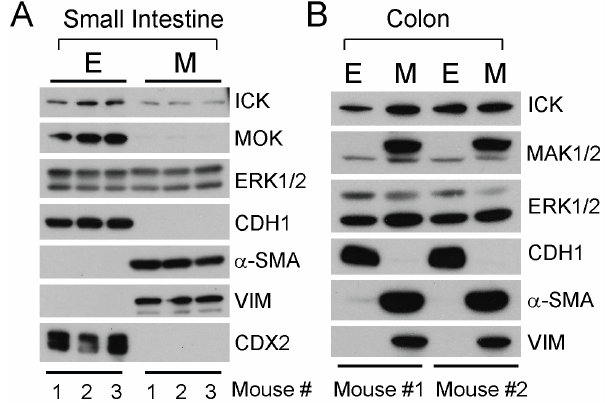
Figure 5. Differential partition of ICK/MAK/MOK proteins between intestinal epithelial and mesenchymal cells. Intestinal epithelial cells and mesenchymal cells were isolated and enriched from small intestine (A) and colon (B) tissues of young adult C57BL/6J mice. ICK/MAK/MOK protein signals in these two distinct cell populations were analyzed on Western blot. The E-Cadherin signal was used as a marker for epithelial cells and the VIM (Vimentin) and a -SMA ( a -Smooth Muscle Actin) signals were used as markers for mesenchymal cells. The ERK1/2 signals were shown to indicate an equal distribution pattern between the epithelial and mesenchymal cell